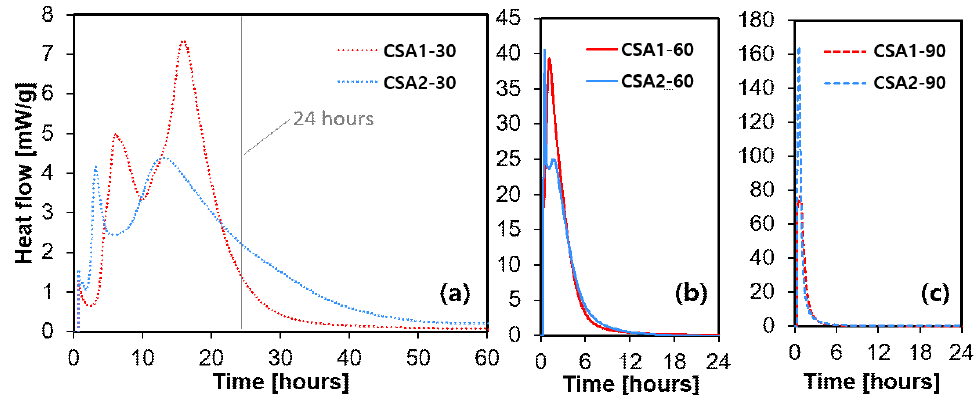
Figure 6. Isothermal conduction calorimetry of each samples cured at ( a ) 30 ◦ C, ( b ) 60 ◦ C and ( c ) 90 ◦ C.